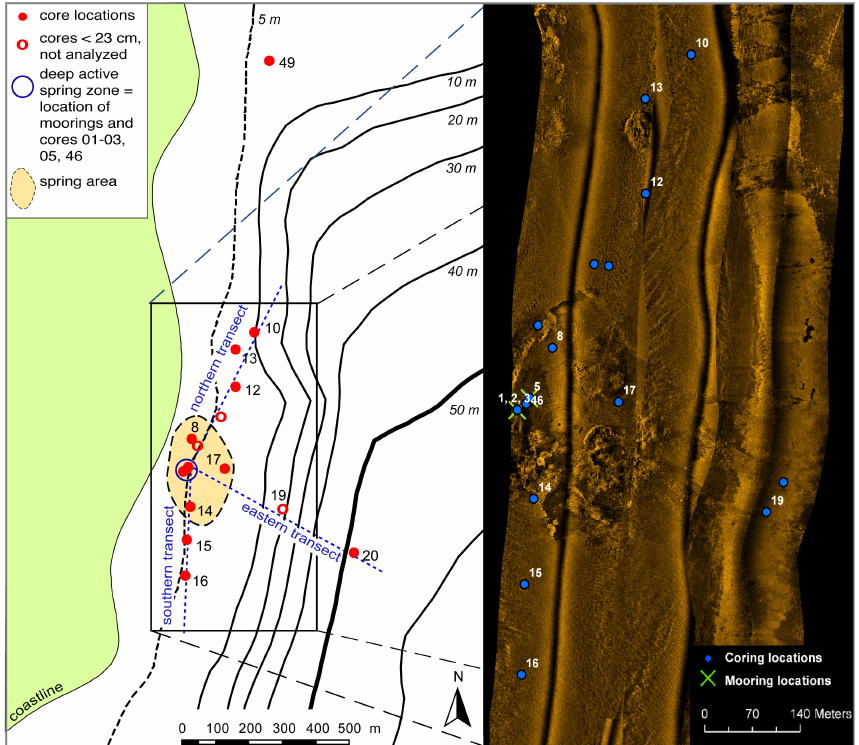
Fig. 2. left: Map of coring transects in the vicinity of the springs with location of main spring area (orange), cores and moorings. Black lines indicate bathymetric contours referring to a lake level of 693m a.s.l. Black rectangle coincides with area of detail map shown right. right: Sidescan sonar image of the spring area and surroundings with mooring locations (green crosses) and coring locations (blue dots). The vertical lines mimic the ship tracks and are sidescan artifacts. Note surface roughness in spring area, indicating partly exposed bedrock and macrophyte